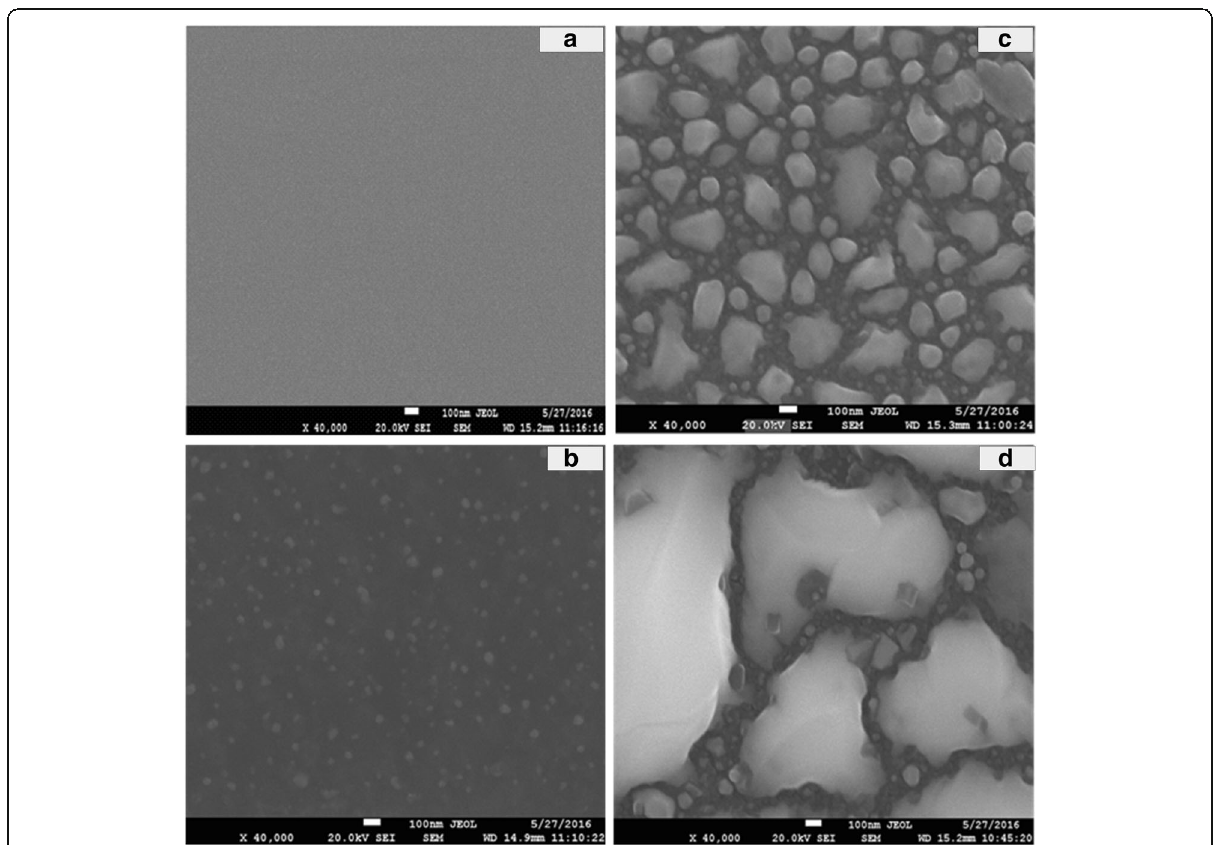
Fig. 2 Typical SEM patterns of GeBi films with different Bi contents: a 2.0%; b 10.2%; c 18.3%; and d